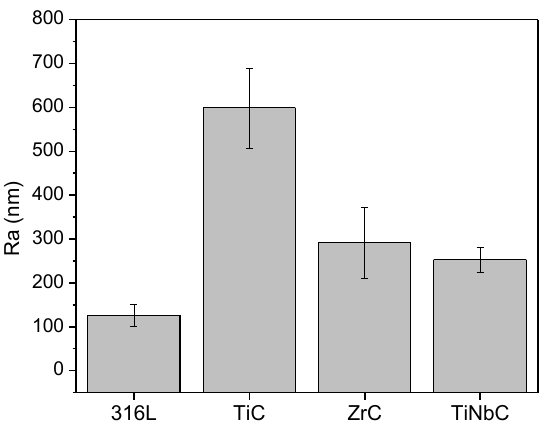
Figure 6. The arithmetic average deviation from the mean line of the roughness profile ( R a ) of substrate and coatings measured on a distance of 4 mm using surface profilometry after the corrosion test in 0.9% NaCl at 37 ± 0.5 °C.